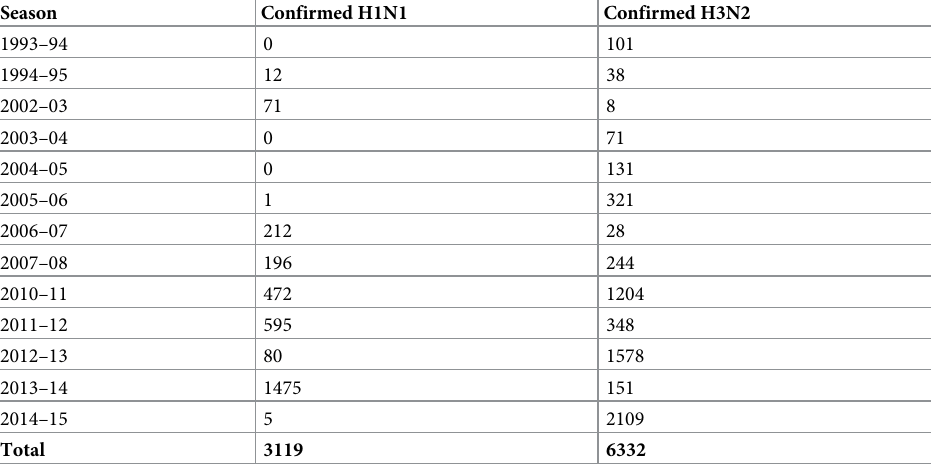
Table 1. PCR-confirmed